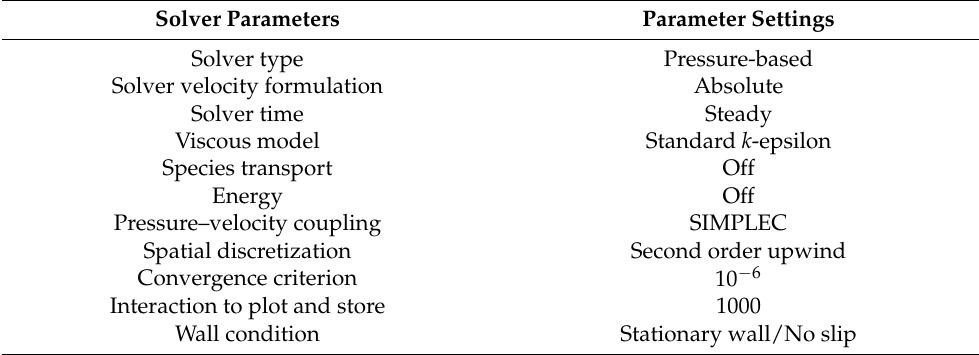
Table 1. Solver parameter settings. Solver Parameters Parameter Settings Solver type Pressure-based Solver velocity formulation Absolute Solver